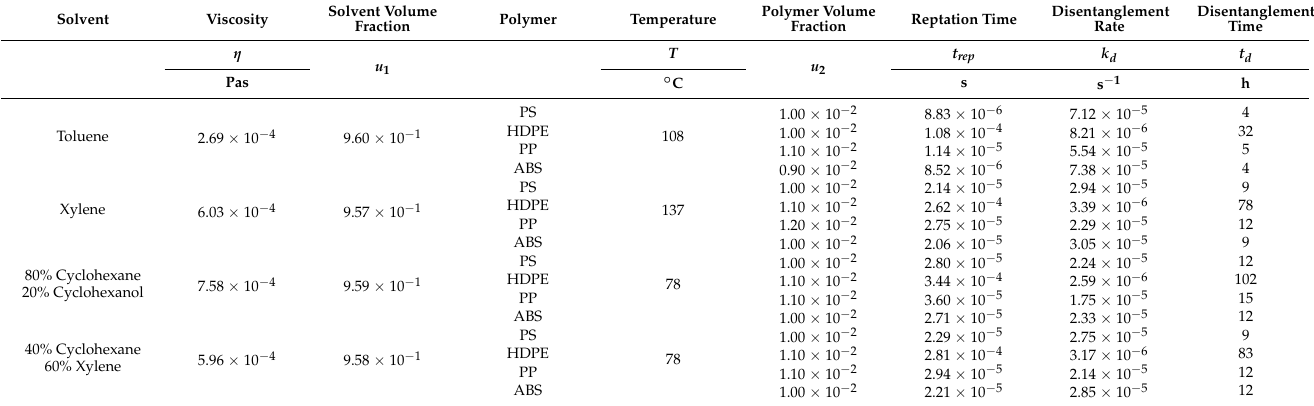
Table 6. Characteristic dissolution times of the plastic feedstock in selected solvent combinations. Viscosity SolventVolume Fraction